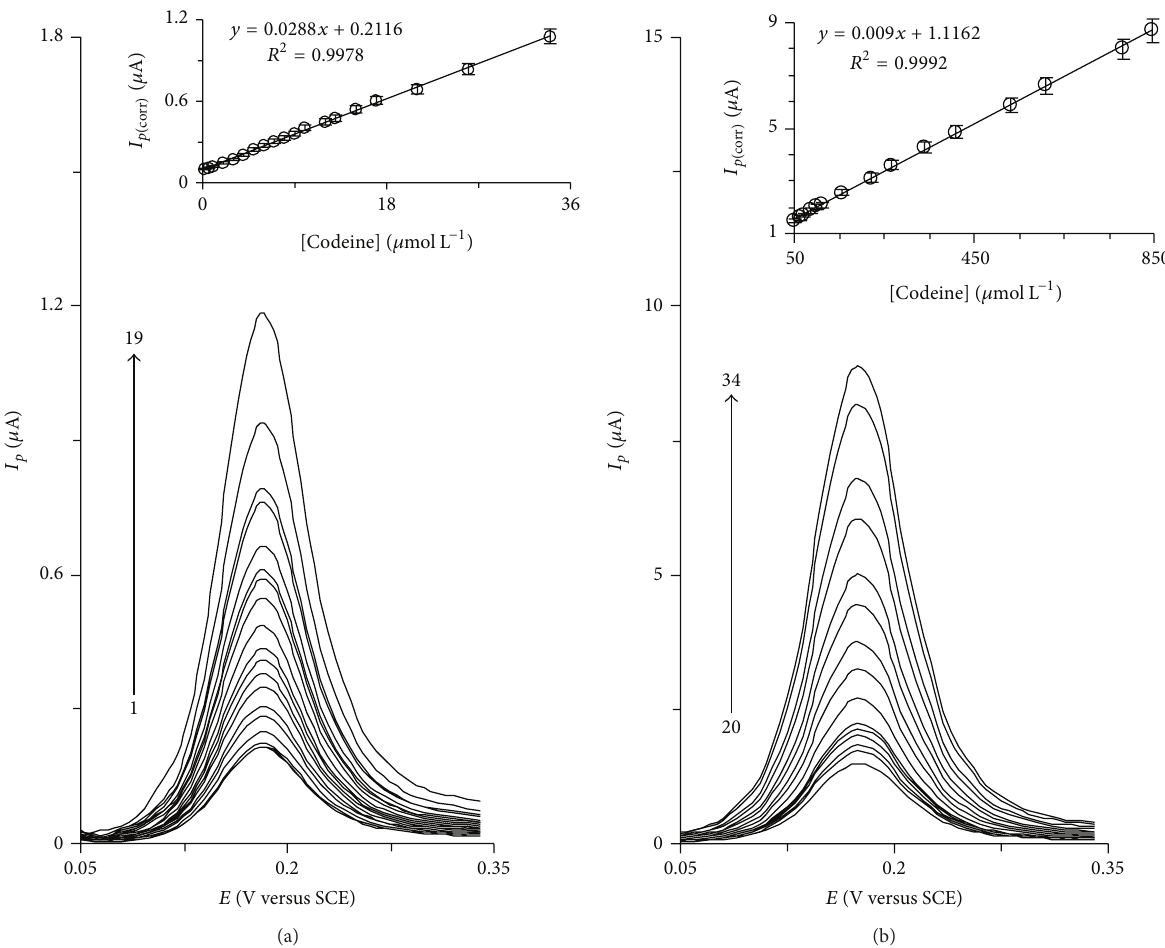
Figure5:(a)and(b)showdifferentialpulsevoltammogramsofHTP-MWCNT-CPEina0.15 Mphosphatebuffersolution(pH7.0)containing different concentrations of codeine. The numbers of 1–19 and 20–34 correspond to 0.2–31.4 𝜇 M and 34.1–844.7 𝜇 M of codeine, respectively. Insets show the plots of electrocatalytic peak currents as a function of codeine concentrations in the ranges of 0.2–31.4 𝜇 M and 34.1–844.7 𝜇 M,